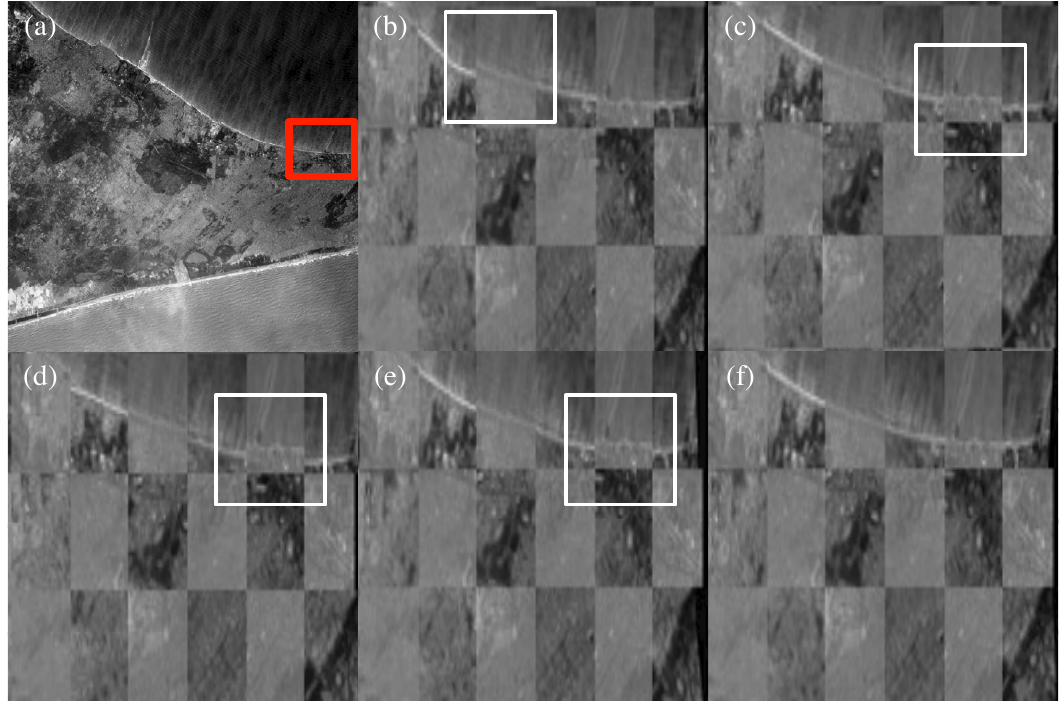
Figure 10. Checkerboard images of Dataset 4: ( a ) sample image; ( b ) SIFT; ( c ) SURF; ( d ) SSD; ( e ) NCC; and ( f ) FZNCC. The white box indicates inaccurately registered